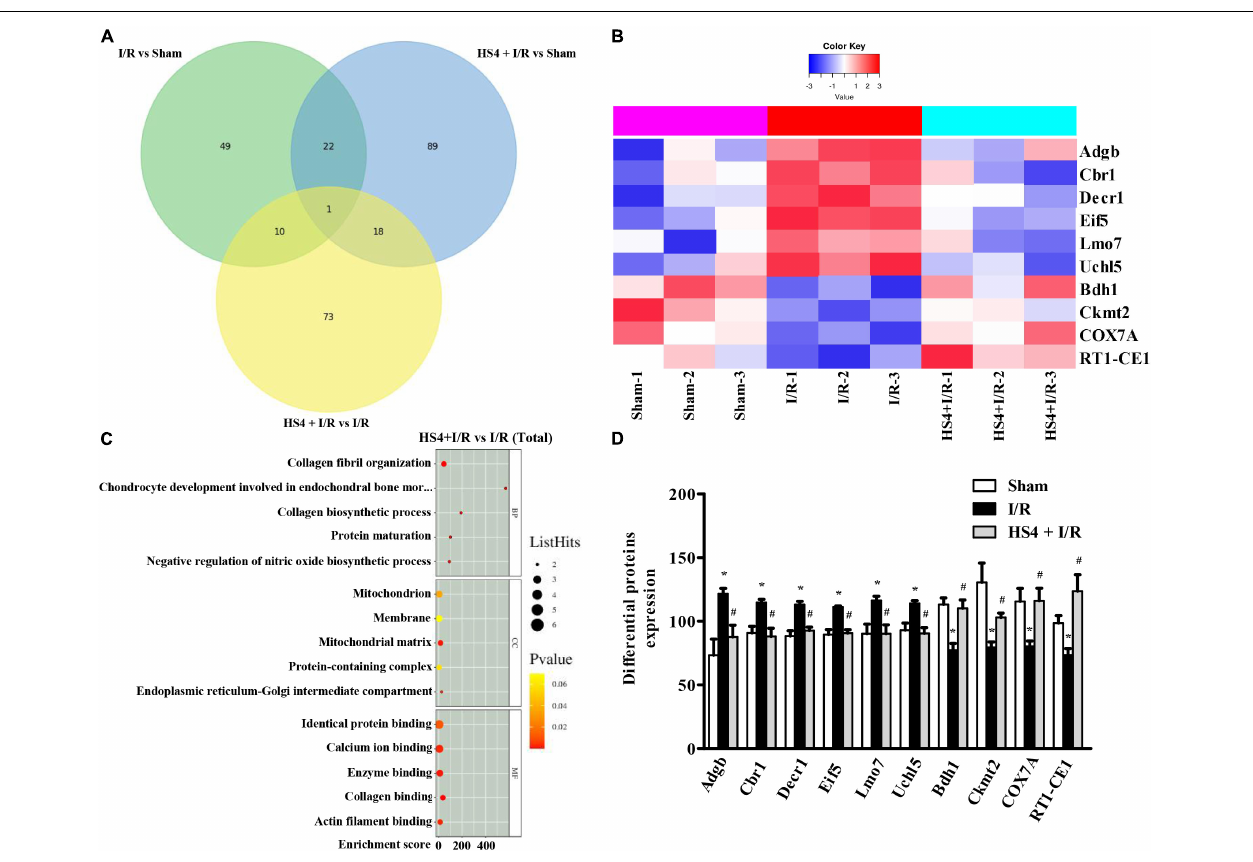
FIGURE 6 | Quantitative proteomics analysis of HS4 + I/R group compared with I/R. (A) The Venn diagram of differentially expressed proteins (DEPs) among the three groups of Sham, I/R, and HS4 + I/R. (B) The bubble diagram of the top 15 enriched GO terms identified between HS4 + I/R group and I/R group using BP, CC, and MF. (C,D) The heat map and quantitative statistics of DEPs in Sham group, I/R group, and HS4 + I/R